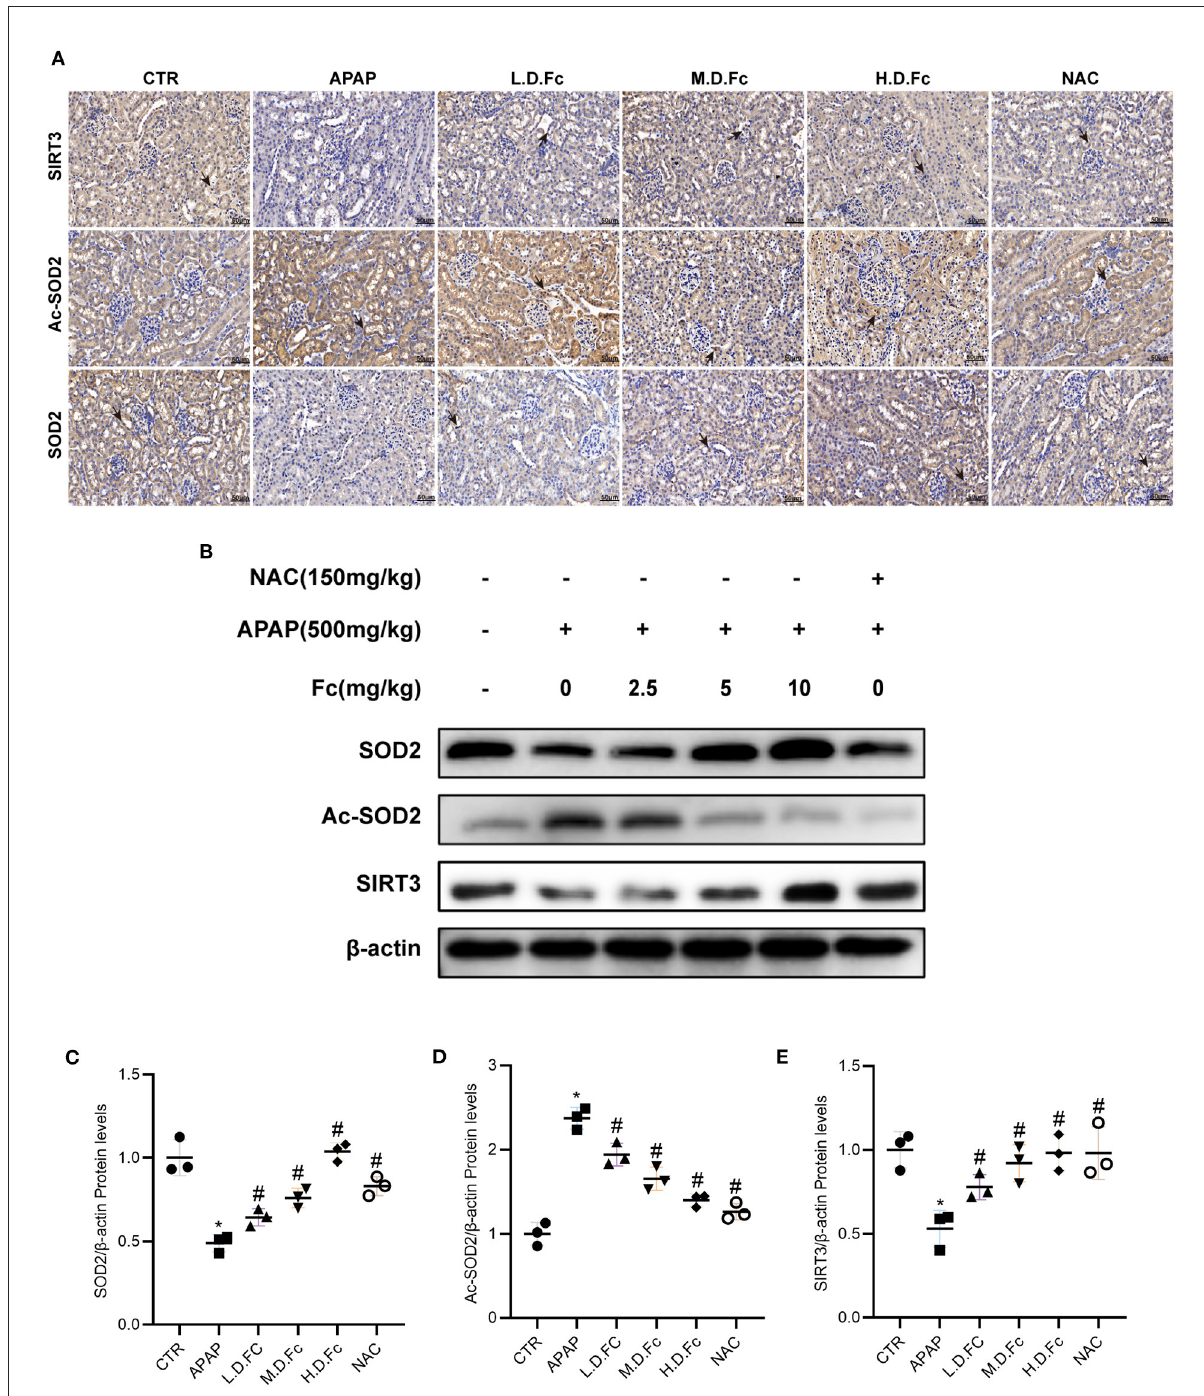
FIGURE4 Notoginsenoside Fc restored the expression of oxidative stress-associated proteins in AKI mice. (A) Representative photographs of immunohistochemistry staining of SIRT3, Ac-SOD2 and SOD2 (original magnification × 400, bars = 50 µ m). (B–E) Representative Western blot images of SIRT3, Ac-SOD2 and SOD2 protein expression and semiquantitative analyses. Results were shown as mean ± SD. * P < 0.05 vs normal control mice. # P < 0.05 vs. APAP-induced AKI